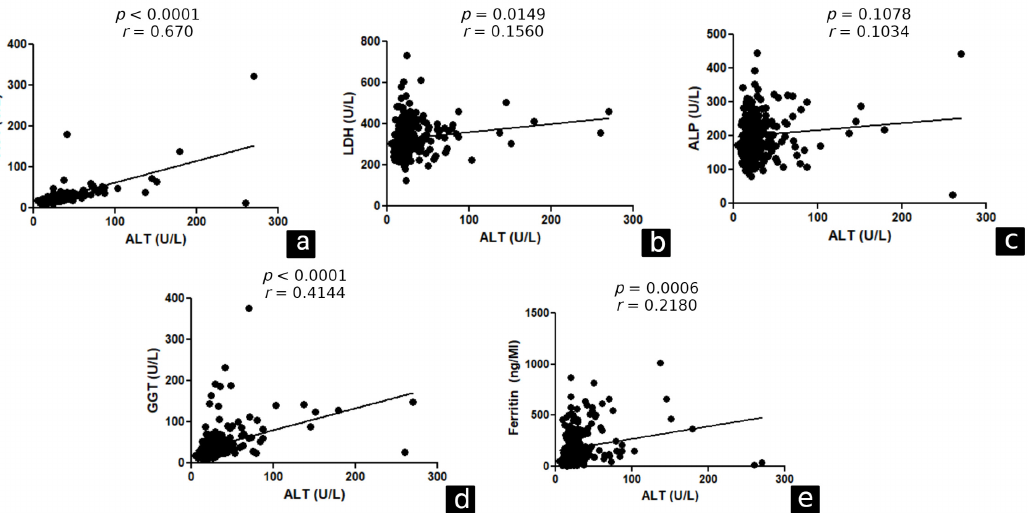
Figure 2. Correlation between ALT and markers of liver function in the general study population.